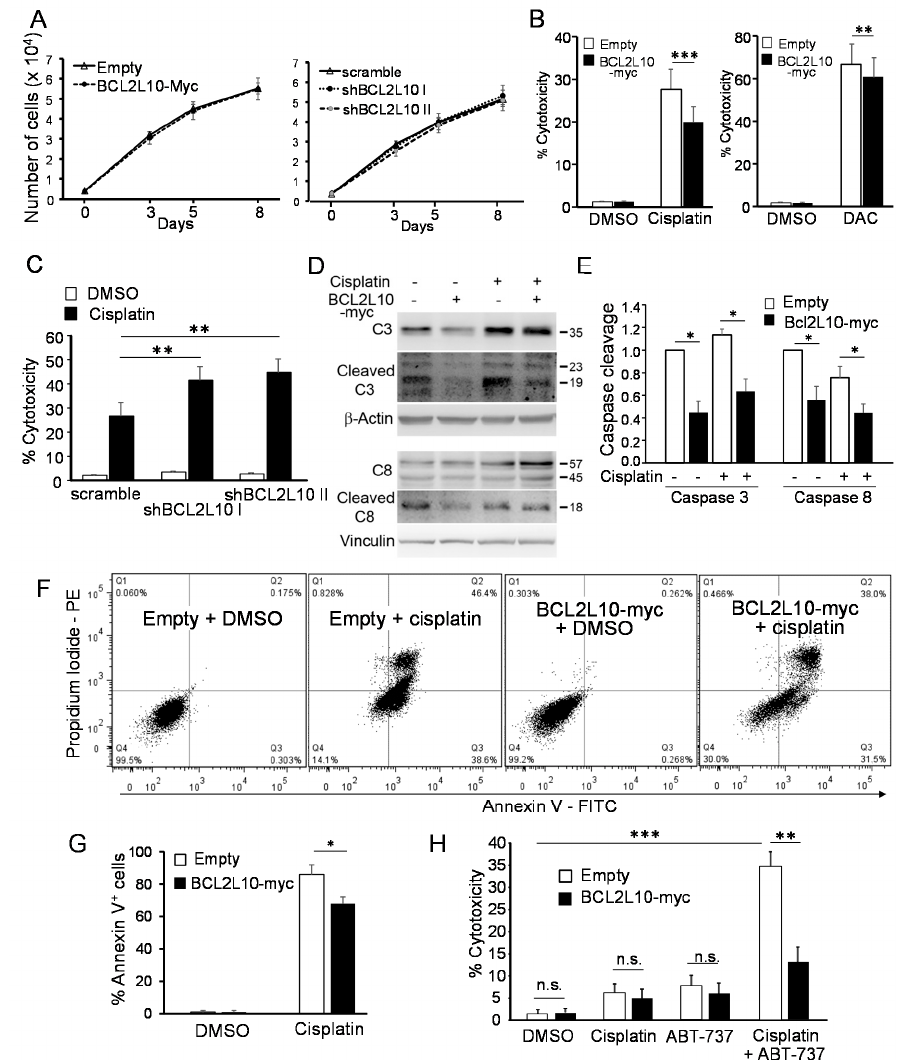
Figure 5. BCL2L10 enhances cell survival in melanoma upon treatment with DNA-damaging agents. ( A ) BCL2L10 does not affect cell growth. M2-empty and M2-BCL2L10-myc (left) and A375-scramble, A375-shBCL2L10 I, and A375-shBCL2L10 II cell lines (right) were grown for 8 days and the cell density was determined using a crystal violet assay. Results are shown as the mean ± SD, n = 3. ( B ) M2-empty and M2-BCL2L10-myc were treated with 40 µ M cisplatin (left) or 100 µ g/mL dacarbazine (DAC, right) for 48 h. Bar graph shows the mean ± SD ( n = 7 for cisplatin and n = 5 for dacarbazine) of the percent of cytotoxicity. The percentage of cytotoxicity was calculated as the quotient between the number of cells in treated wells and the number of cells in non-treated wells times 100. ( C ) A375-scramble, A375-shBCL2L10 I, and A375-shBCL2L10 II cells were treated with cisplatin (40 µ M) for 48 h. Bar graph shows the mean ± SD (from three independent experiments) of the percent of cytotoxicity. ( D ) M2-empty and M2-BCL2L10-myc were treated with 40 µ M cisplatin for 24 h. Protein extracts were probed with antibodies against full-length caspase 3 (C3), cleaved caspase 3 (cleaved C3) or caspase 8 (C8). β -actin and vinculin were used as loading control. The blots displayed are representative of three independent experiments. ( E ) Bar graphs show the ratio (mean ± SD) between cleaved (19 kDa fragment for caspase 3 and 18 kDa fragment for caspase 8) and uncleaved full-length caspase 3 or caspase 8 from the experiment in ( D ). This ratio is expressed as the fold change relative to the ratio measured in DMSO-treated M2-empty cells. *: p < 0.05, n = 3. ( F ) M2-empty and M2-BCL2L10-myc were treated with 40 µ M cisplatin for 24 h, stained with PI/annexin V and analyzed by flow cytometry. Representative histograms are shown. ( G ) Bar graph shows the mean ± SD ( n = 3) of the percentage of annexin V positive cells from the experiment in ( F ). * p < 0.05, n = 3. ( H ) M2-empty and M2-BCL2L10-myc cells were treated with ABT-737 (2.5 µ M), cisplatin (10 µ M) or ABT-737 (2.5 µ M) plus cisplatin (10 µ M). Bar graph shows the mean ± SD (from three independent experiments) of the percent of cytotoxicity. The statistical analysis is described in Methods. **: p < 0.01, ***: p < 0.001, ns: not significant, n = 3. Whole Western blot figures are provided in Supplemental Materials Figure